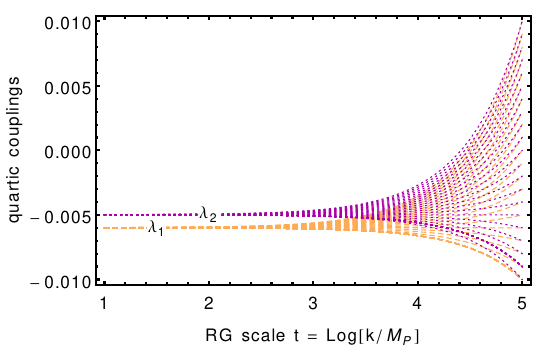
Figure 1 . Transplanckian running of the two quartic couplings of a scalar transforming in the adjoint representation of SU(5), i.e., (cid:21) 1 and (cid:21) 2 as in eq. (2.3), as orange-dashed and purple-dotted lines, respectively. The running is obtained by numerically evolving eqs. (2.4), (2.5) with N = 5, constant A = 2 and constant (cid:11) = 1 = 40. The quartic couplings have been initialized on a grid of points on the interval [ (cid:0) 0 : 01 ; 0 : 01]